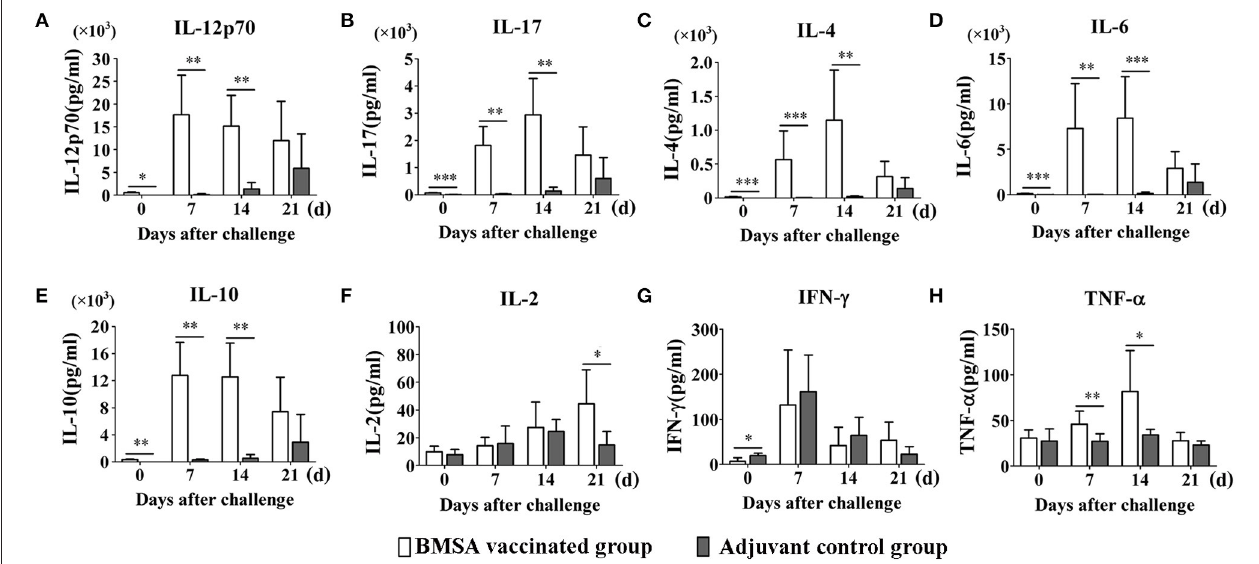
FIGURE 4 | Cytokine levels in sera of mice immunized with BMSA or Tris-HCl. BALB/c mice of the BMSA vaccinated or adjuvant control groups were followed by a challenge with 1 × 10 7 erythrocytes infected with B. microti and were sampled on days 0, 7, 14, and 21. (A–H) The levels of IFN- γ , TNF- α , IL-2, IL-12p70, IL-17, IL-4, IL-6, and IL-10 in serum were determined using a Mouse Cytokine/Chemokine Magnetic Bead Panel. The data represent two individual experiments (* p < 0.05; ** p < 0.01; *** p <